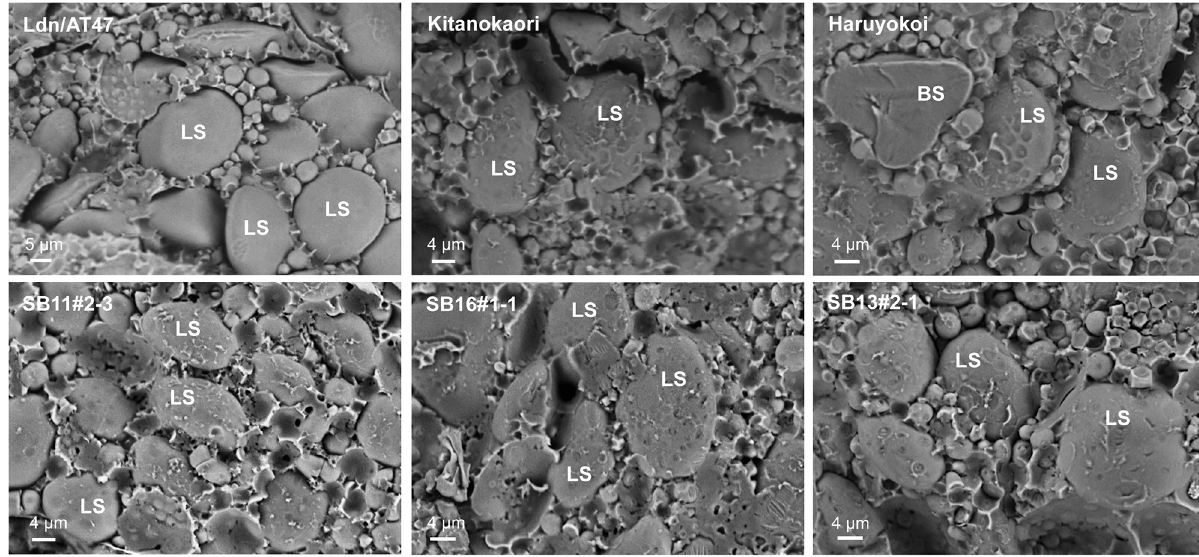
Fig 3. Scanning electron micrographs of grain sections of the synthetic hexaploid wheat line (Ldn/AT47), two parental bread wheat cultivars (Kitanokaori and Haruyokoi), and three selected early heading lines. Photos of transverse sections of mature grains are shown for each accession. LS; large starch granule, BS; broken large starch granule.